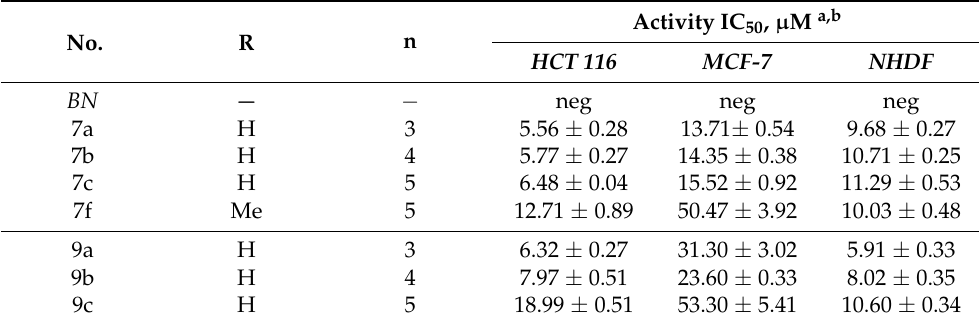
Table 2. A summary of the cytotoxic effects of BN, 28-TPP ⊕ BN ( 7 ), and 3,28- bis TPP ⊕ BN ( 9 ) on the HCT 116 and MCF-7 cancer cell lines and